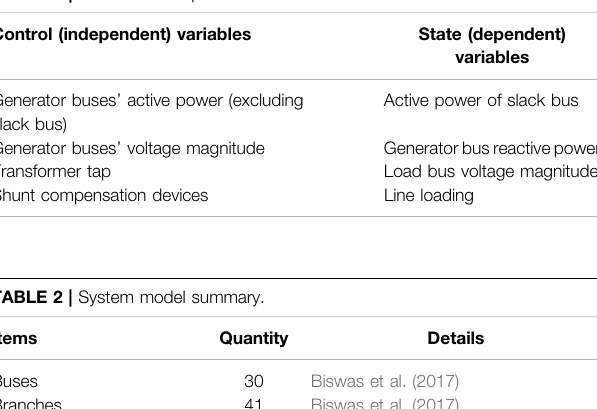
TABLE 1 | Control and dependent variables.